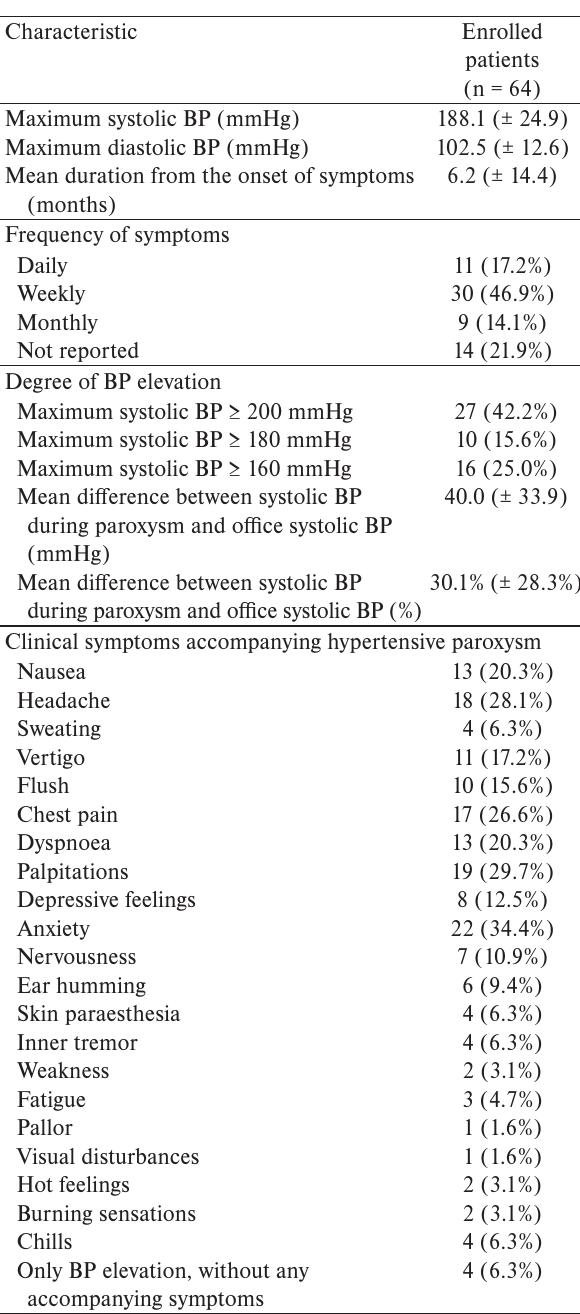
Table 2. Characteristics of hypertensive